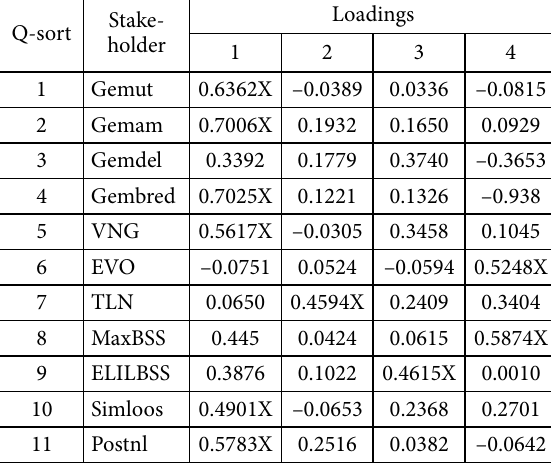
Table 3. Factor loadings generated with the Varimax